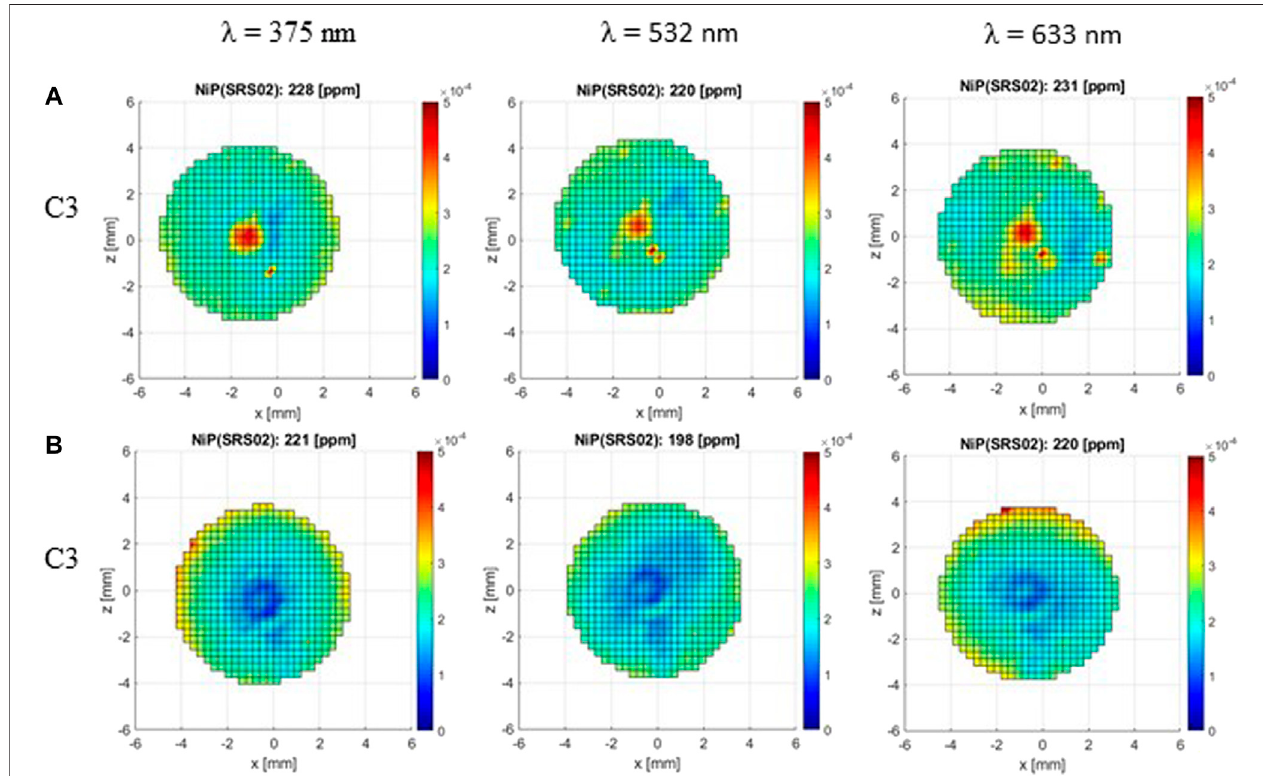
FIGURE 8 | Re fl ectance map of two cavities (C3 (A)/top and C3 (B)/bottom) with a curved tube at the apogee for the wavelengths: 375, 532, and 633 nm. The upper value of each panel represents the average re fl ectance in ppm calculated from maps.